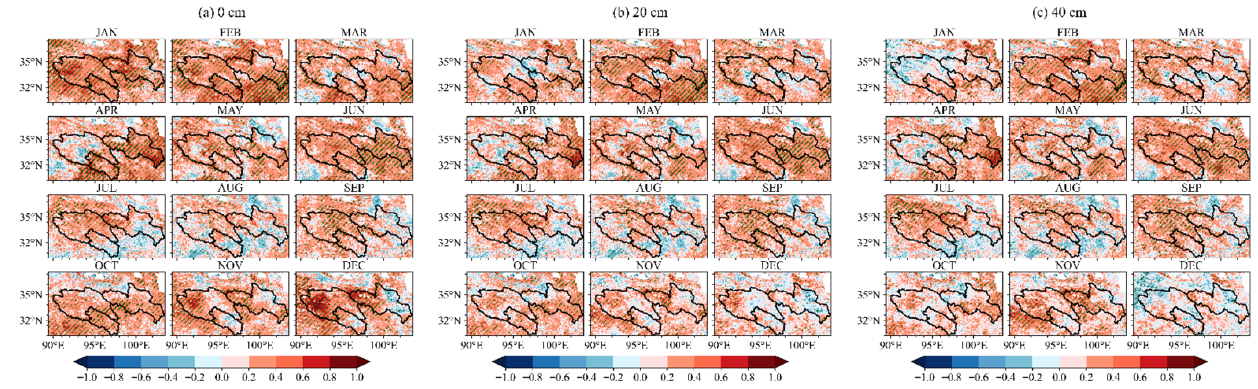
nificant negative correlation with soil temperature in the southeast, with vegetation play ‐